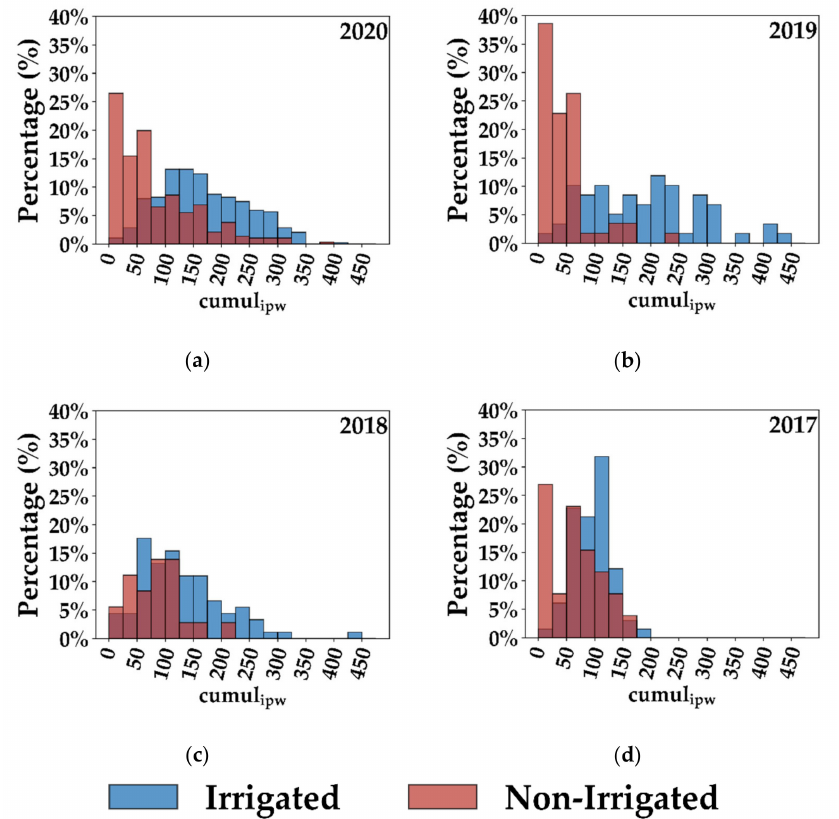
Figure 7. Distribution of the cumulative irrigation metric “ cumul ipw ” for in situ irrigated (blue bars) and non-irrigated (red bars) plots for ( a ) 2020, ( b ) 2019, ( c ) 2018, and ( d ) 2017. The overlap between irrigated and non-irrigated classes appears with dark red color. The cumul ipw is